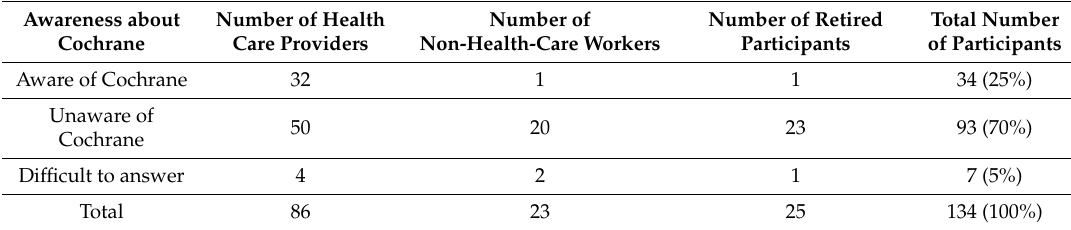
Table 10. Participants’ awareness of Cochrane and Cochrane work.